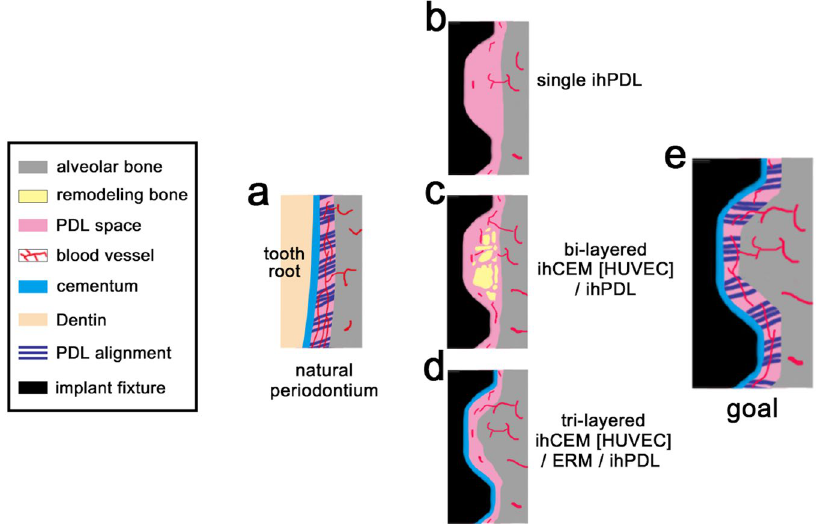
Figure 4. Schematic representation of the bio-implant. ( a ) The natural periodontium contains cementum, PDL connecting alveolar bone and cementum, and blood vessels. ( b ) The ihPDLs sheet bio-implant shows PDL- like connective tissue formation; however, the vertically aligned PDL-like tissue cannot function. A few blood vessels are engaged in the PDL-like tissue. ( c ) The ihCEM [HUVEC]/ihPDL bi-layered cell sheet bio-implant. Bone remodelling occurred between the threads of the fixture and the blood vessels around the remodelled bone. ( d ) The ihCEM [HUVEC]/ERM/ihPDL tri-layered cell sheet bio-implant shows rapid bone healing and thin cementum-like calcified tissue on the fixture. The PDL space was narrower than the bi-layered bio-implant. ( e ) Final goal of the bio-implant. The PDL connects alveolar bone with properly formed cementum on the fixture. The width of the PDL space is precisely regulated for optimal